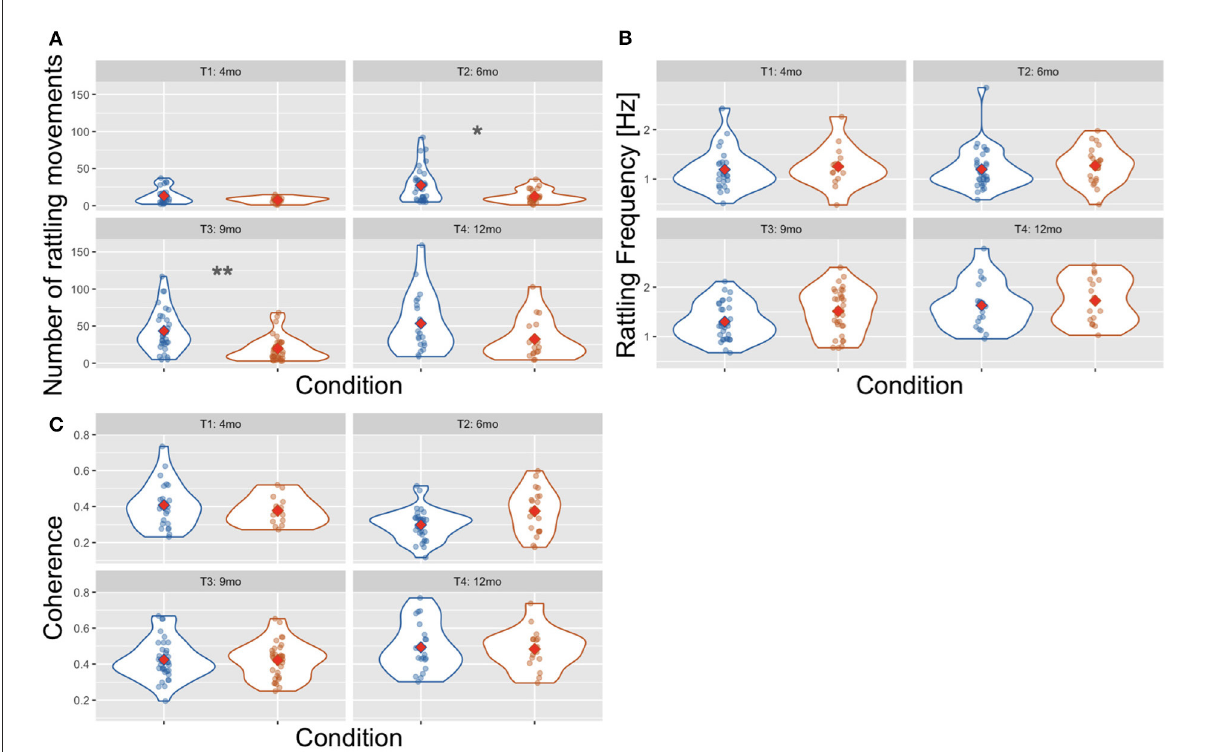
FIGURE7 Violin plot showing the number of rattling movements (A) , the frequency of rattling (B) , and the between-arms coherence (C) across time points and conditions: Mother Not Providing Rhythm (blue) and Mother Providing Rhythm (orange). Red diamonds indicate mean values, a single asterisk indicates significance at p < 0.05, and two asterisks indicate p <